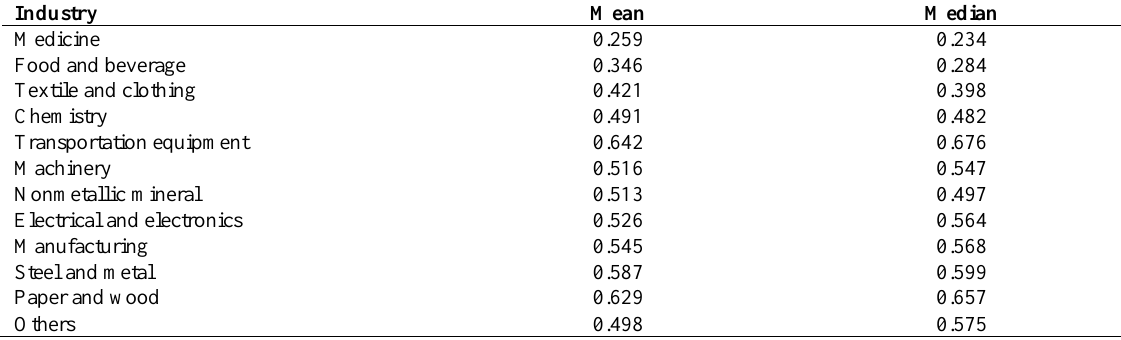
Table 3: Union coverage for each